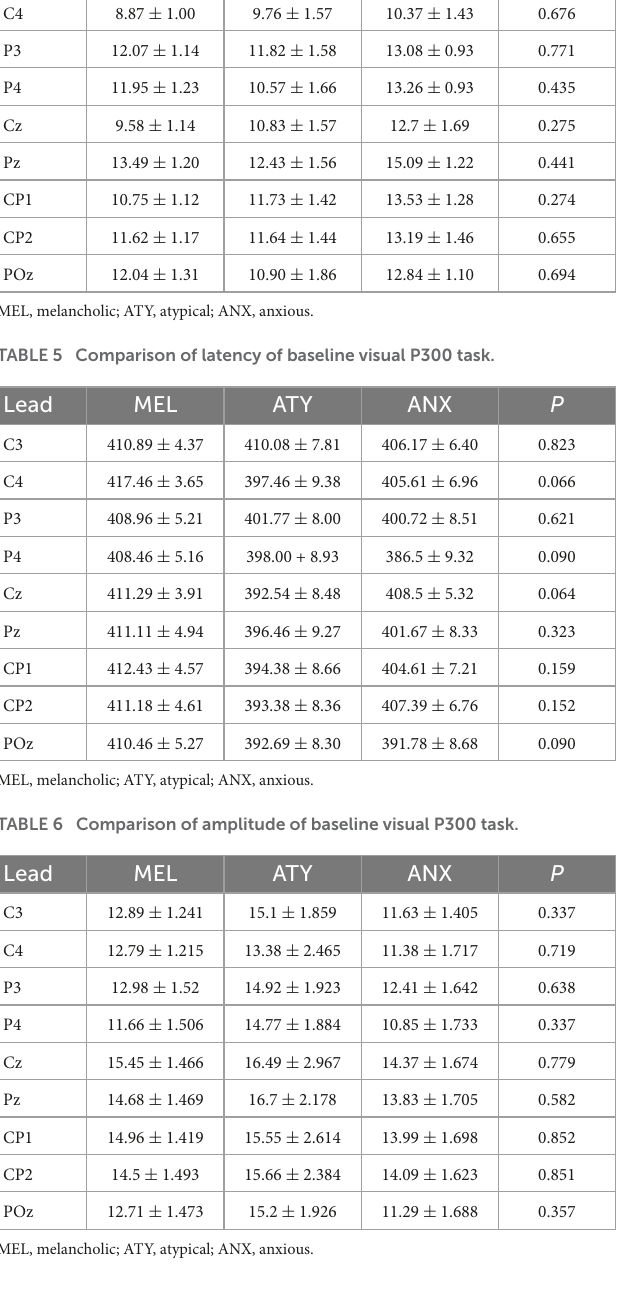
TABLE 2 Comparison of the clinical characteristics of the patients. Scale MEL ATY ANX P HAMD-17